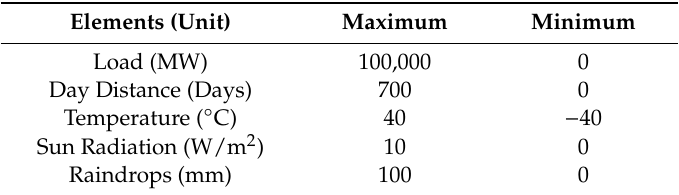
Table 1. Normalization criteria for the simulation data.